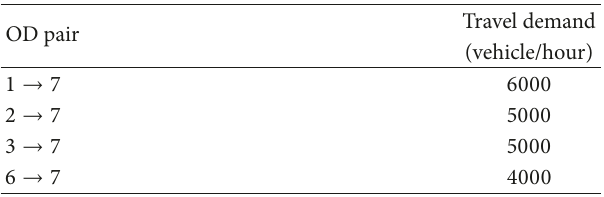
Table 1: OD demand.